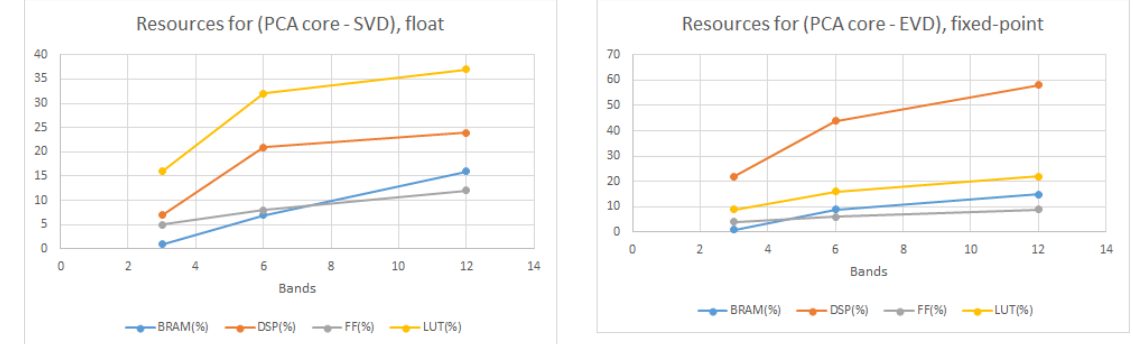
Figure 14. Latency for Zynq7000 with a fixed block size ( B max = 3), pixels = 300 × 300.